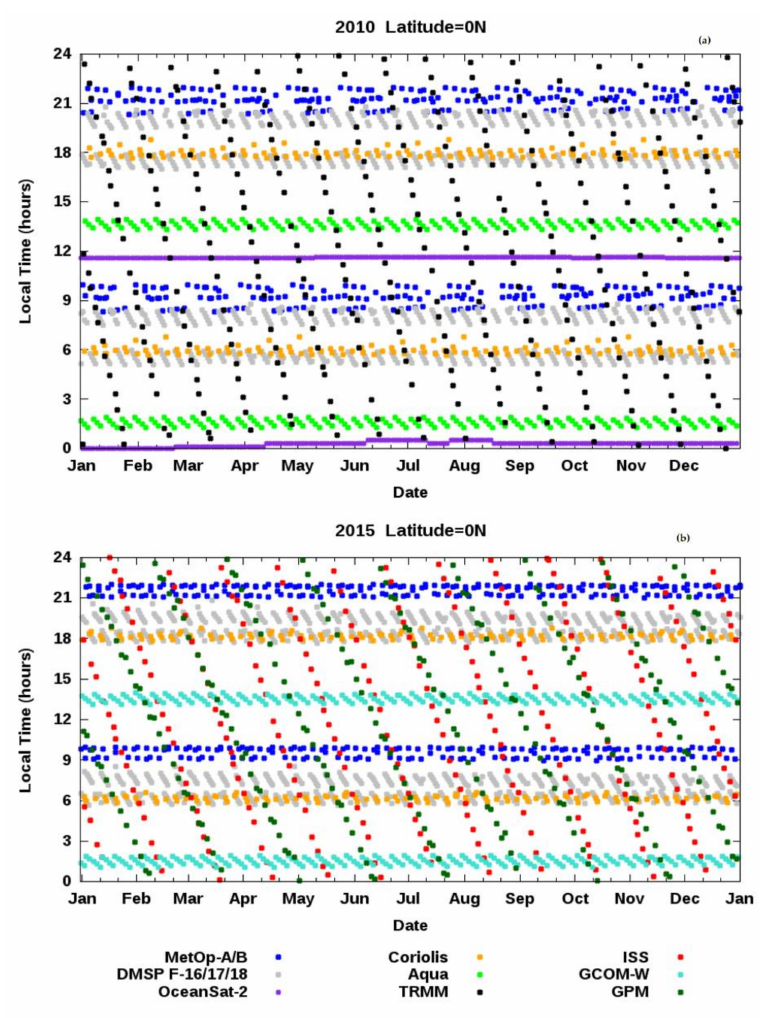
Figure 2. Time series of the local time of observation for a location at the equator, for the collection of wind radiometers and scatterometers (Table 1) available during 2010 ( a ) and 2015 ( b